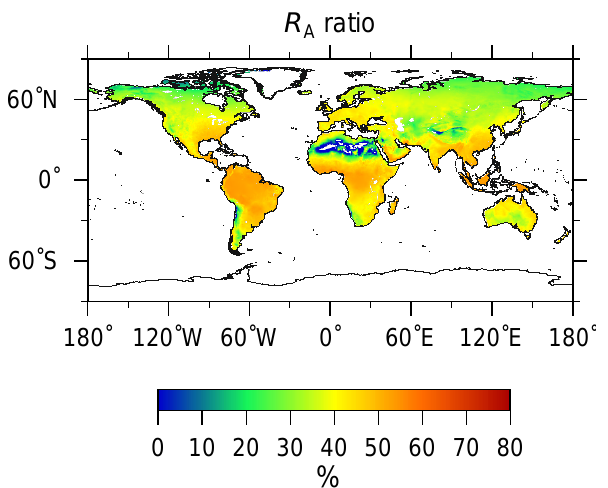
Figure 9. Comparison of global heterotrophic respiration. The grey bars are the results from the 20 Earth system models of the CMIP5 (1965–2004; please see Table S2). The orange line represents the result of this study. The blue line indicates the mean of the results of the 20 Earth system